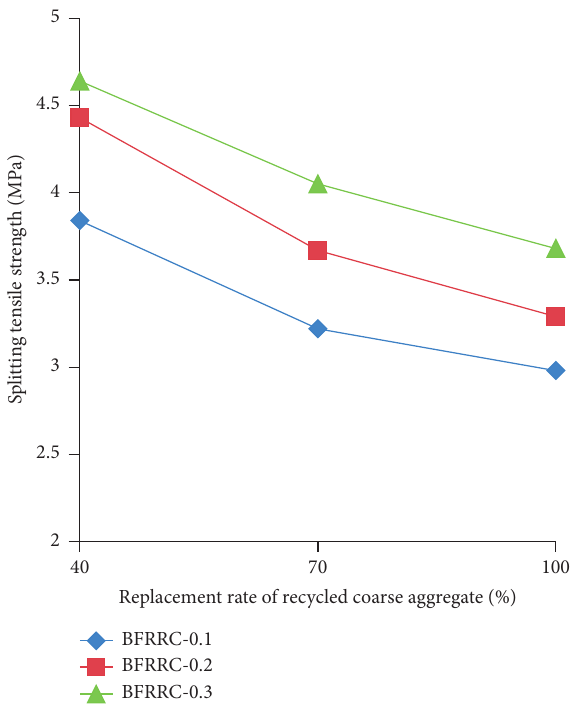
Figure 6: Curve of splitting tensile strength of BFRRC.